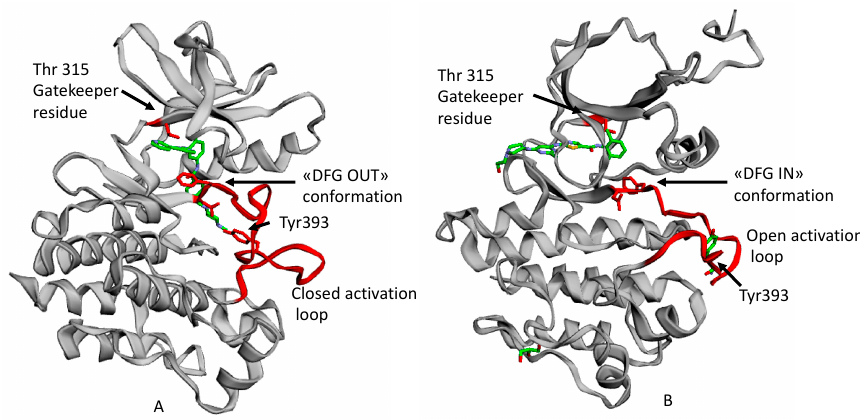
Figure 1. An example of ATP competitive inhibitors: ( A ) X-ray solved structure of Abl kinase domain in complex with Imatinib (PDB code: 1IEP) with DFG outconformation and closed activation loop. ( B ) X-ray solved structure of Abl Kinase domain with Dasatinib (PDB code: 2GQG) with DFG in conformation, open activation loop [5].